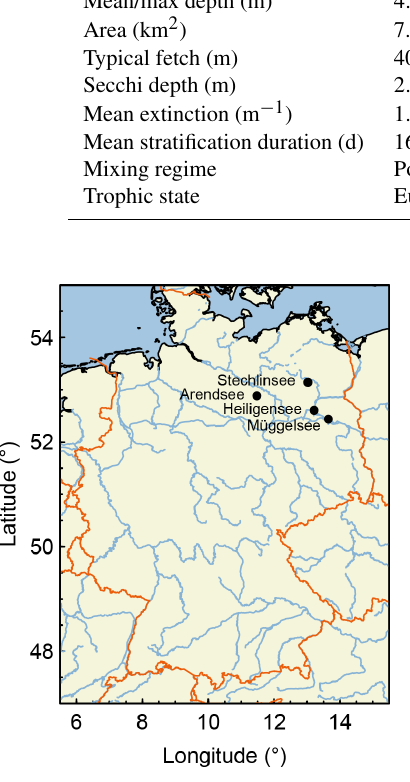
Figure 1. Locations of the study lakes in